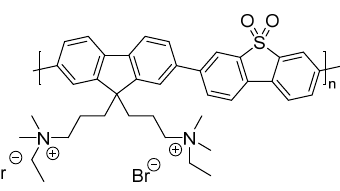
Figure 23. Structure of the conjugated polyelectrolyte incorporating the dibenzo[ b , d ]thiophene sulfone [116].